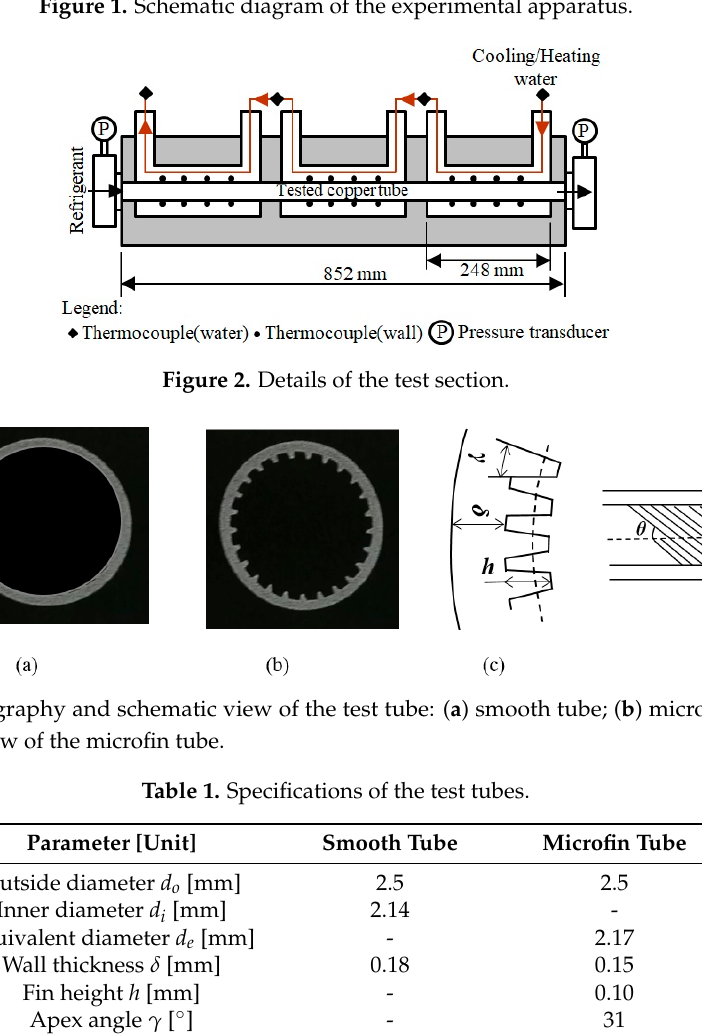
Figure 1. Schematic diagram of the experimental apparatus.